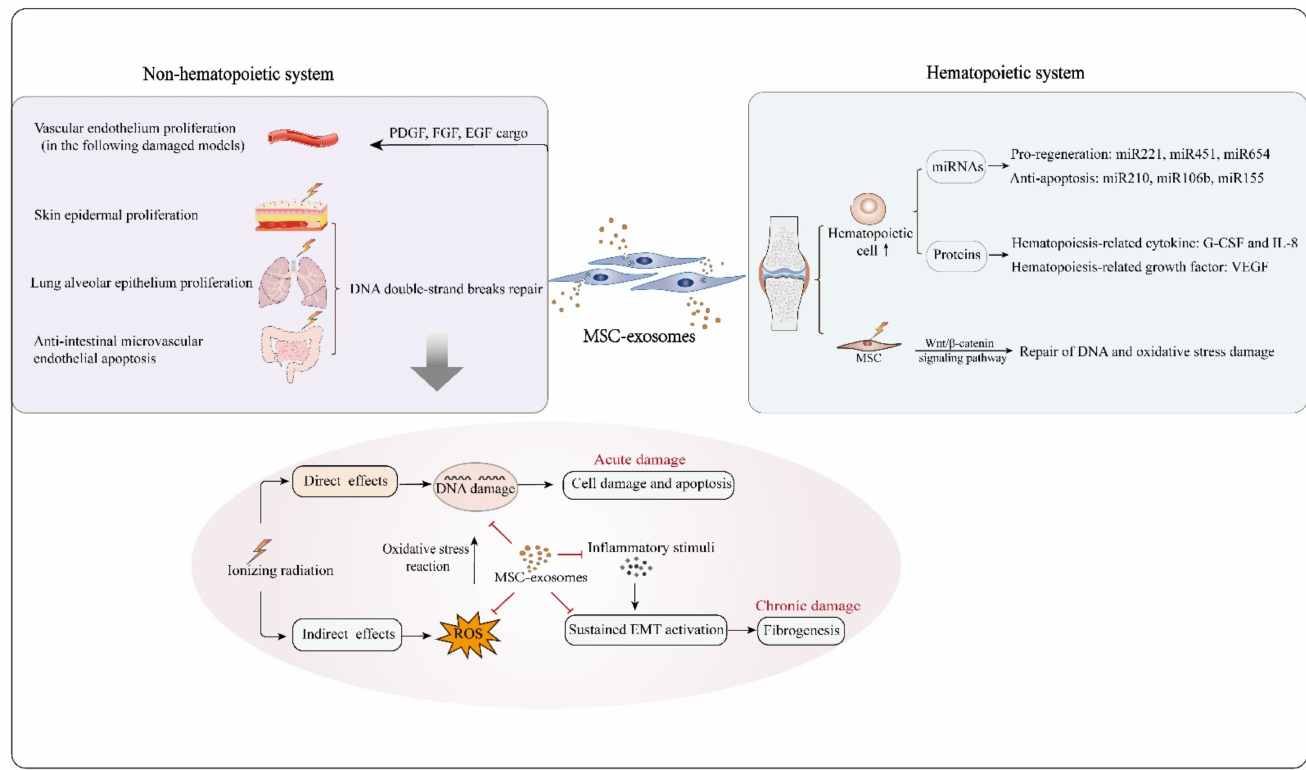
Figure 2. MSC-exosomes are capable of protecting against radiation-induced damage to hematopoietic and nonhematopoi- etic systems. In hematopoietic reconstruction post irradiation, MSC-exosomes enhance hematopoietic cell survival and proliferation by carrying functional molecules, such as the pro-regeneration miRNAs miRNA221, miRNA451 and miRNA654, the anti-apoptosis-related miRNAs miRNA210, miRNA106b and miRNA155, the hematopoiesis-related cytokines G-CSF and IL-8, and the hematopoiesis-related growth factor VEGF. In addition, MSC-exosomes can protect irradiated bone marrow MSCs from radiation-induced DNA and oxidative stress damage by activating the Wnt/ β -catenin signaling pathway. With regard to the non-hematopoietic system, MSC-exosomes reduce apoptosis of skin epidermal, lung alveolar epithelium and intestinal epithelium cells, as MSC-exosomal miRNAs likely mediate repair of DNA double-strand breaks in damaged cells. Oxidative stress reaction and DNA damage are the major processes in radiation damage. MSC-exosomes can overcome these crucial events effectively, and have potential to suppress the development of acute and chronic radiation damage from several aspects. MSC-exosomes also facilitate vascular endothelium proliferation owing to their bioactive cargo molecules, such as PDGF, FGF and